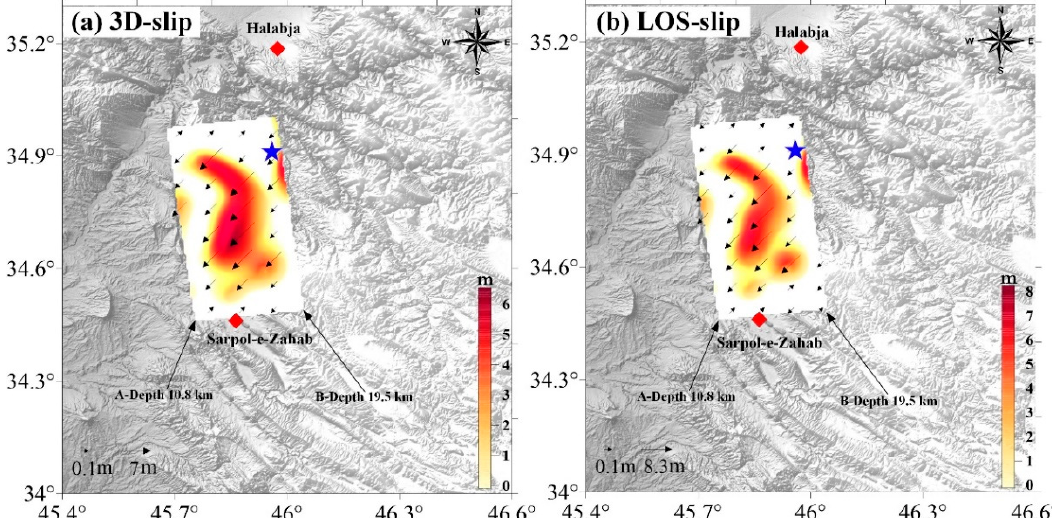
Figure 6. Schematic view of the source mechanism. ( a , b ) are source mechanism based on the 3D deformation data sets and the line-of-sight (LOS) deformation data sets, respectively. The blue star represents the epicenter of the mainshock. The red solid squares represent the city Halabja and Sarpol-e-Zahab. The arrows in ( a , b ) are the slip vectors.